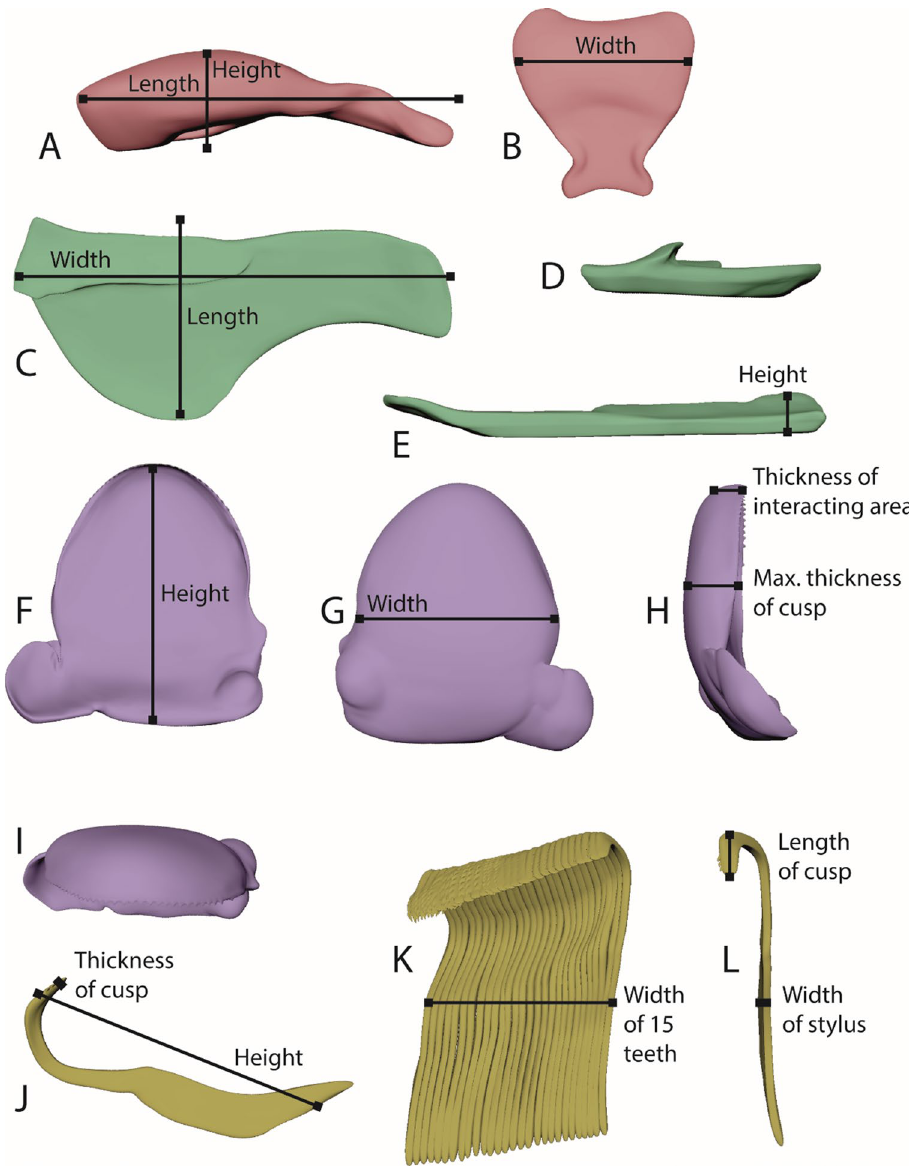
Figure 8. 3D models of distinct tooth types for defining parameters measured (height, width, length, thickness). ( A , B ) Central tooth. ( A ) Lateral view. ( B ) Ventral view. ( C – E ) Lateral tooth I. ( C ) Ventral view. ( D ) Medial view. ( E ) View from anterior. ( F – I ) Lateral tooth II. ( F ) View from posterior. ( G ) View from anterior. ( H ) Lateral view. ( I ) Ventral view. ( J – L ) Inner marginal teeth. ( J ) Lateral view. ( K – L ) Ventral